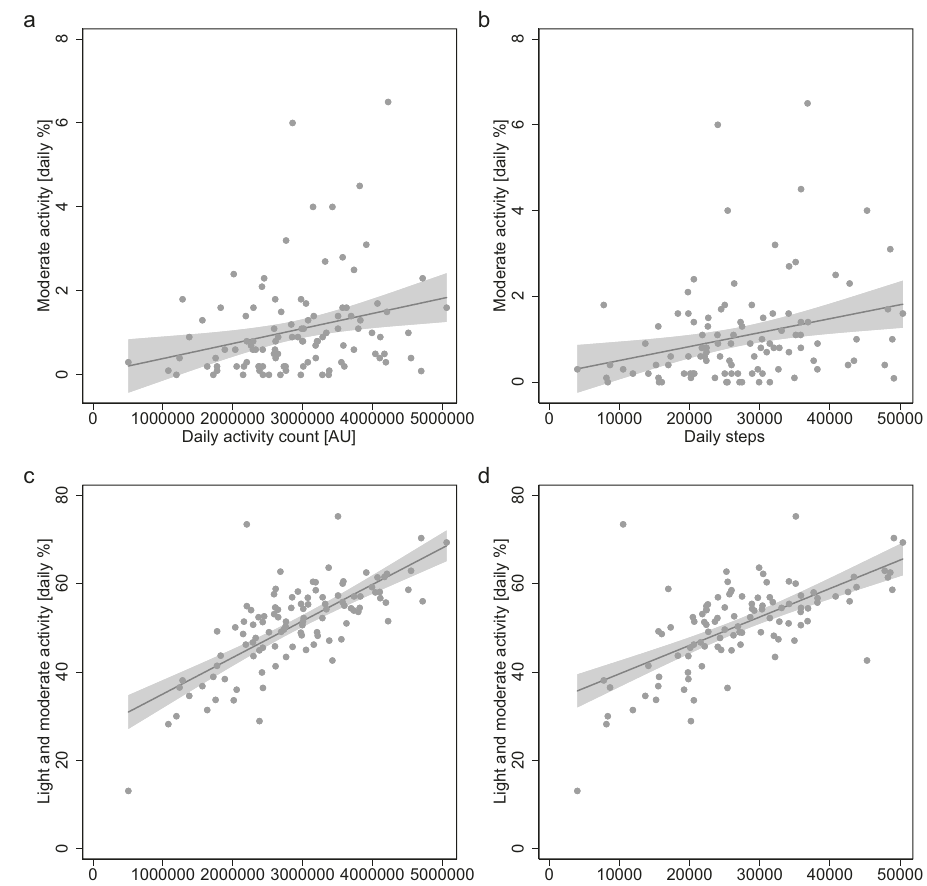
Fig. 2 Relationship between steps and activity counts, recorded by the device at different heart rate-based activity levels. a Daily activity counts measured by the wrist-worn device plotted against daily time spent in moderate activity ( R 2 = 0.087, p = 0.002). b Daily steps plotted against daily time spent in moderate activity ( R 2 = 0.08, p = 0.003). c Daily activity counts plotted against time spent in combined light and moderate activity ( R 2 = 0.539, p < 0.001). d Daily steps plotted against time spent in combined light and moderate activity ( R 2 = 0.422, p < 0.001). AU arbitrary